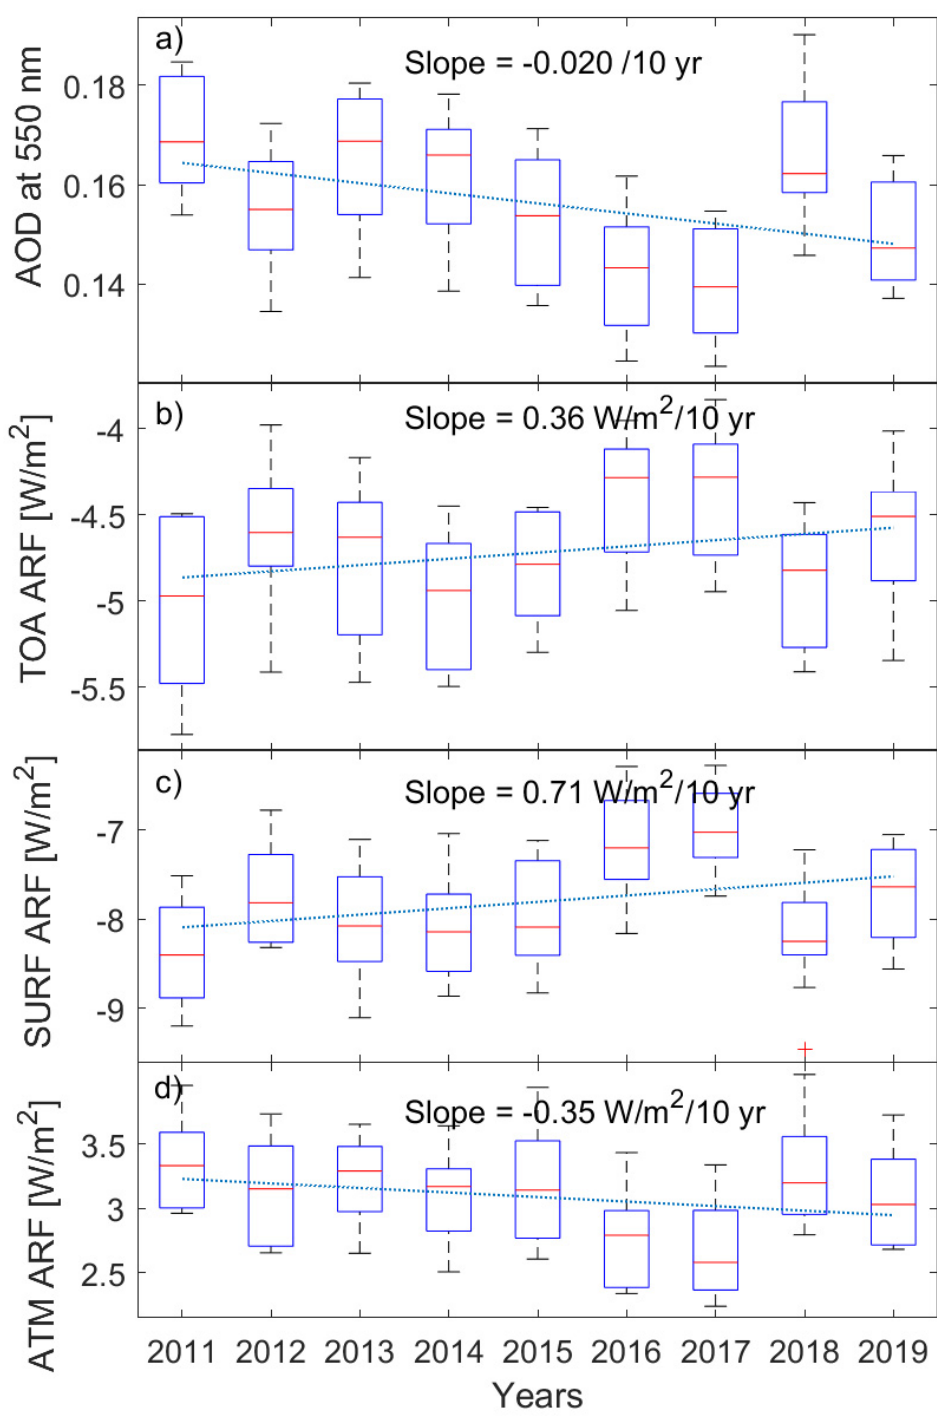
Figure 5. Box-whisker plots for annual mean AOD at 550 nm ( a ), clear-sky the TOA ARF ( b ), surface ARF ( c ), and atmosphere ARF ( d ) in [W/m 2 ] for Poland-AOD sites. The red horizontal lines show the median values. The lower and upper boxes correspond to lower (0.25) and upper (0.75) quantiles, while short horizontal lines show the lowest and highest values. The dotted lines show the linear fit.